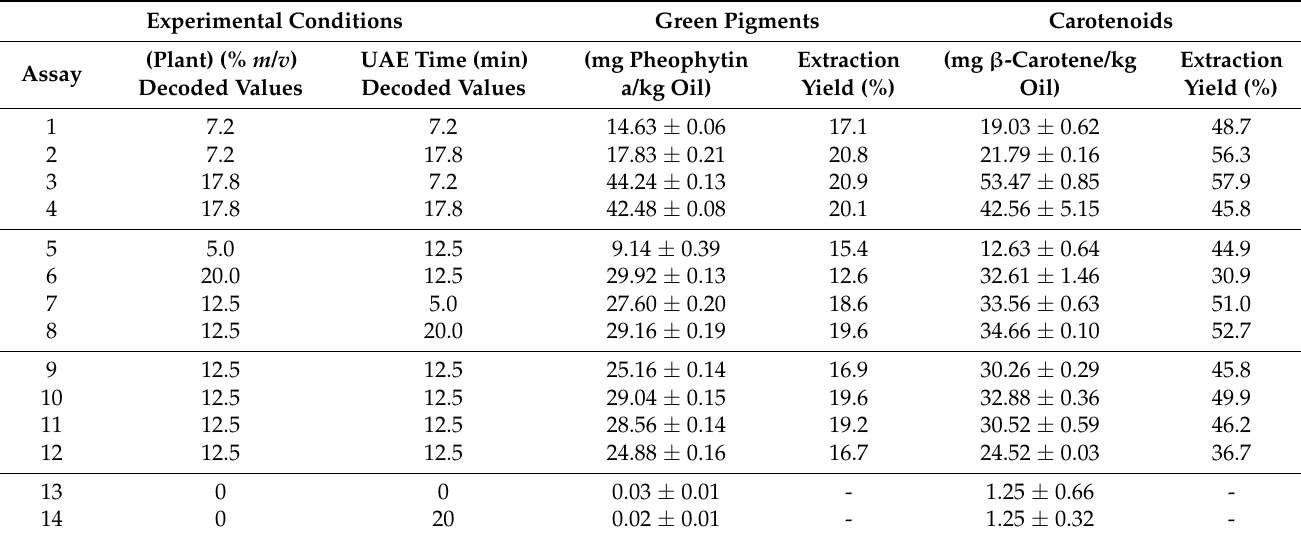
Figure 2. Samples of original (first sample) and supplemented sunflower oil samples with C. maritimum extracts by UAE. The extraction conditions of supplemented samples 1 to 9 correspond to those presented in Table 3. Table 3. CCRD results of the green pigments (expressed in mg pheophytin a/kg oil) and carotenoids (expressed in mg β -carotene/kg oil) contents for each sample of supplemented sunflower oil. Sample 13 is the original refined sunflower oil and sample 14 is the original refined oil after a 20 min ultrasound treatment (average values ± standard deviations of three replicates).